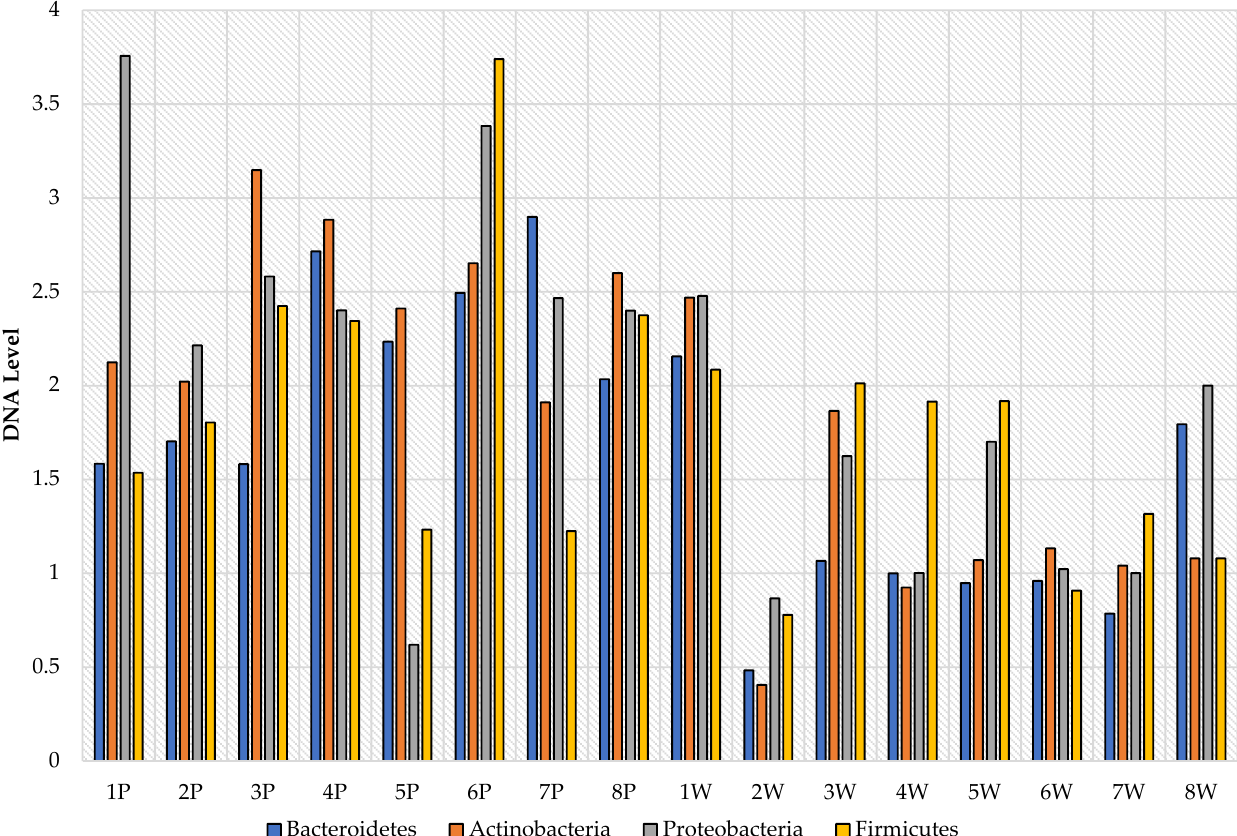
Figure 3. Individual levels of selected bacterial phyla (RNE) in the gastrointestinal tract of ewes based on feces (P—primiparous, W—multiparous).